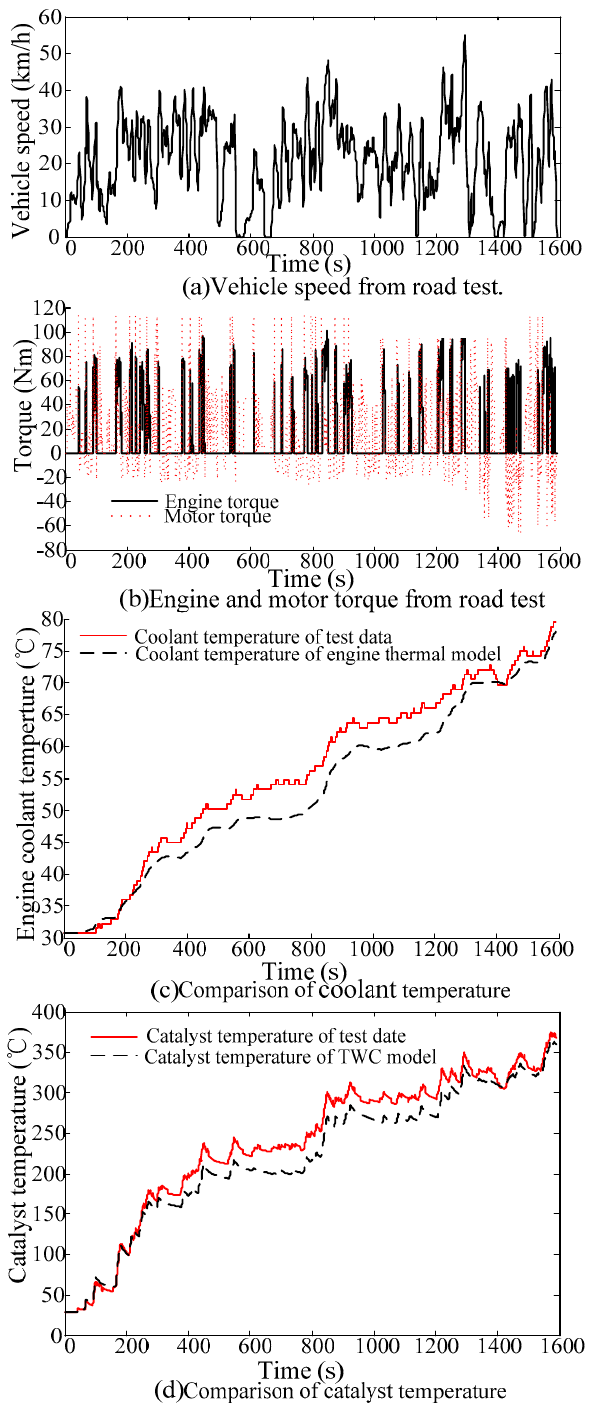
Figure 10. Model validation by comparing model temperature with test data temperature.